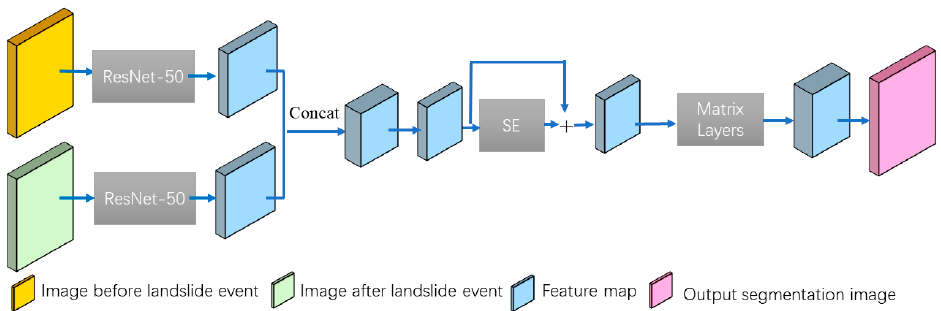
Figure 2. Proposed semantic segmentation network architecture, wherein the concat operation indicates the concatenation of two feature maps, + means the addition operation of the input feature map and output feature map of the SE module.